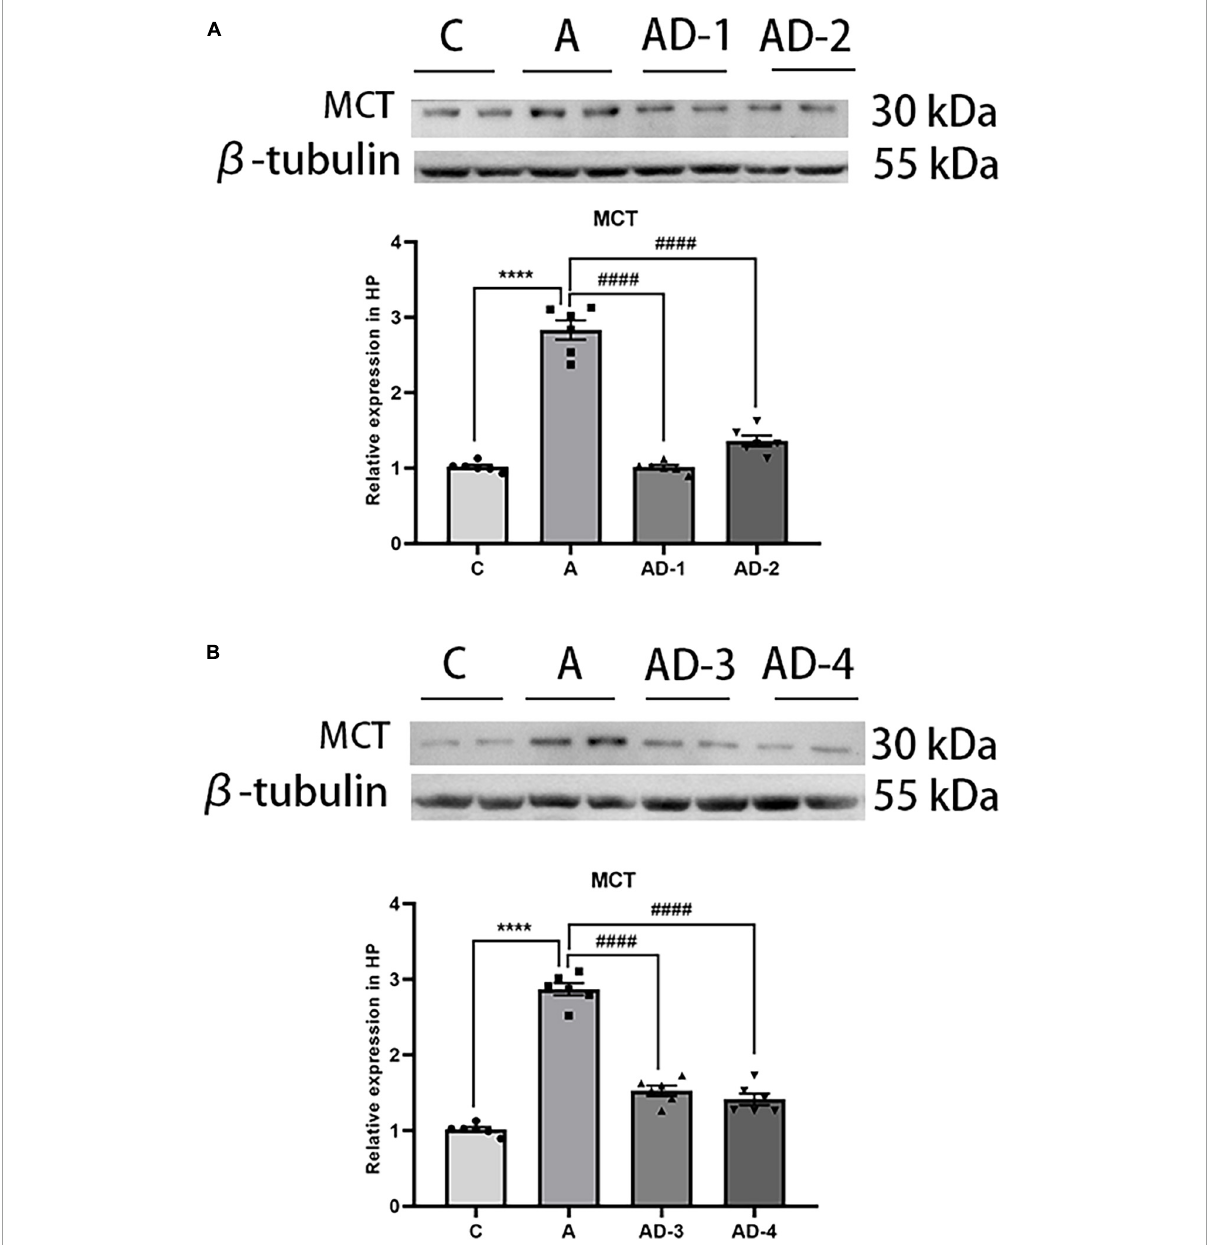
FIGURE2 Effects of different treatment doses and durations of Disodium cromoglycate (DSCG) on mast cell tryptase (MCT) expression in hippocampus. (A) Representative western blot images and graphic presentation of MCT protein abundance after 2 weeks DSCG treatment. (B) Representative western blot images and graphic presentation of MCT protein abundance after 3 weeks DSCG treatment. Results are median ± S.E.M ( n = 6) with the presence of individual animal data in the bar graphs. Results were analyzed by one-way analysis of variance (ANOVA) followed by